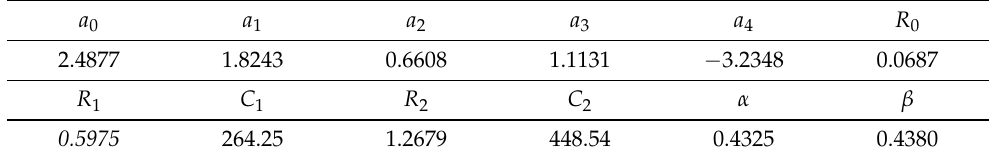
Table 1. The results of the fractional-model parameter identification.